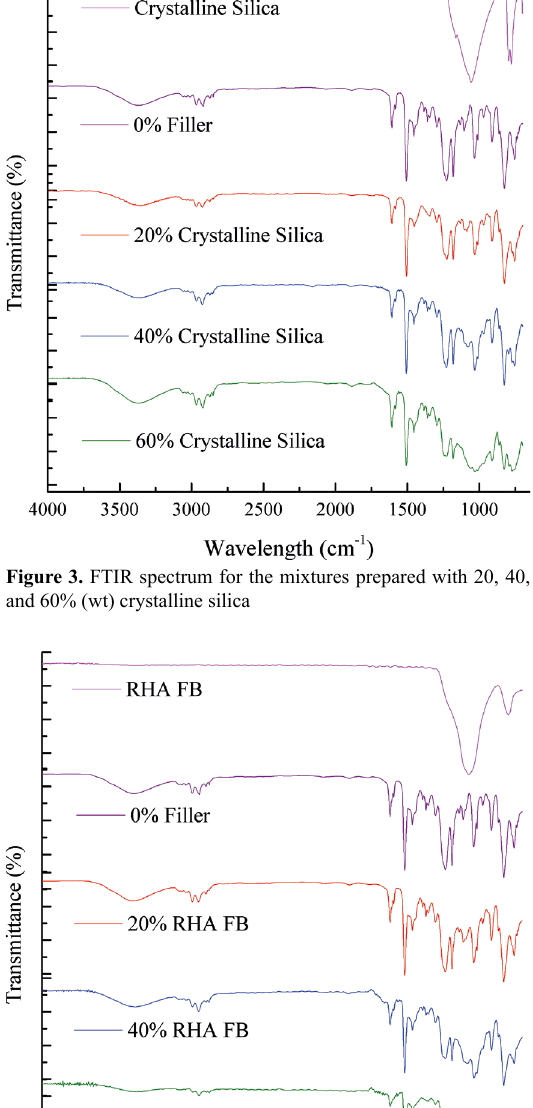
No endothermic peaks were observed in the samples analyzed, indicating no vaporization of water, additives, or other volatiles. All samples had exothermic peaks, which are associated with the epoxy resin curing reaction. Two